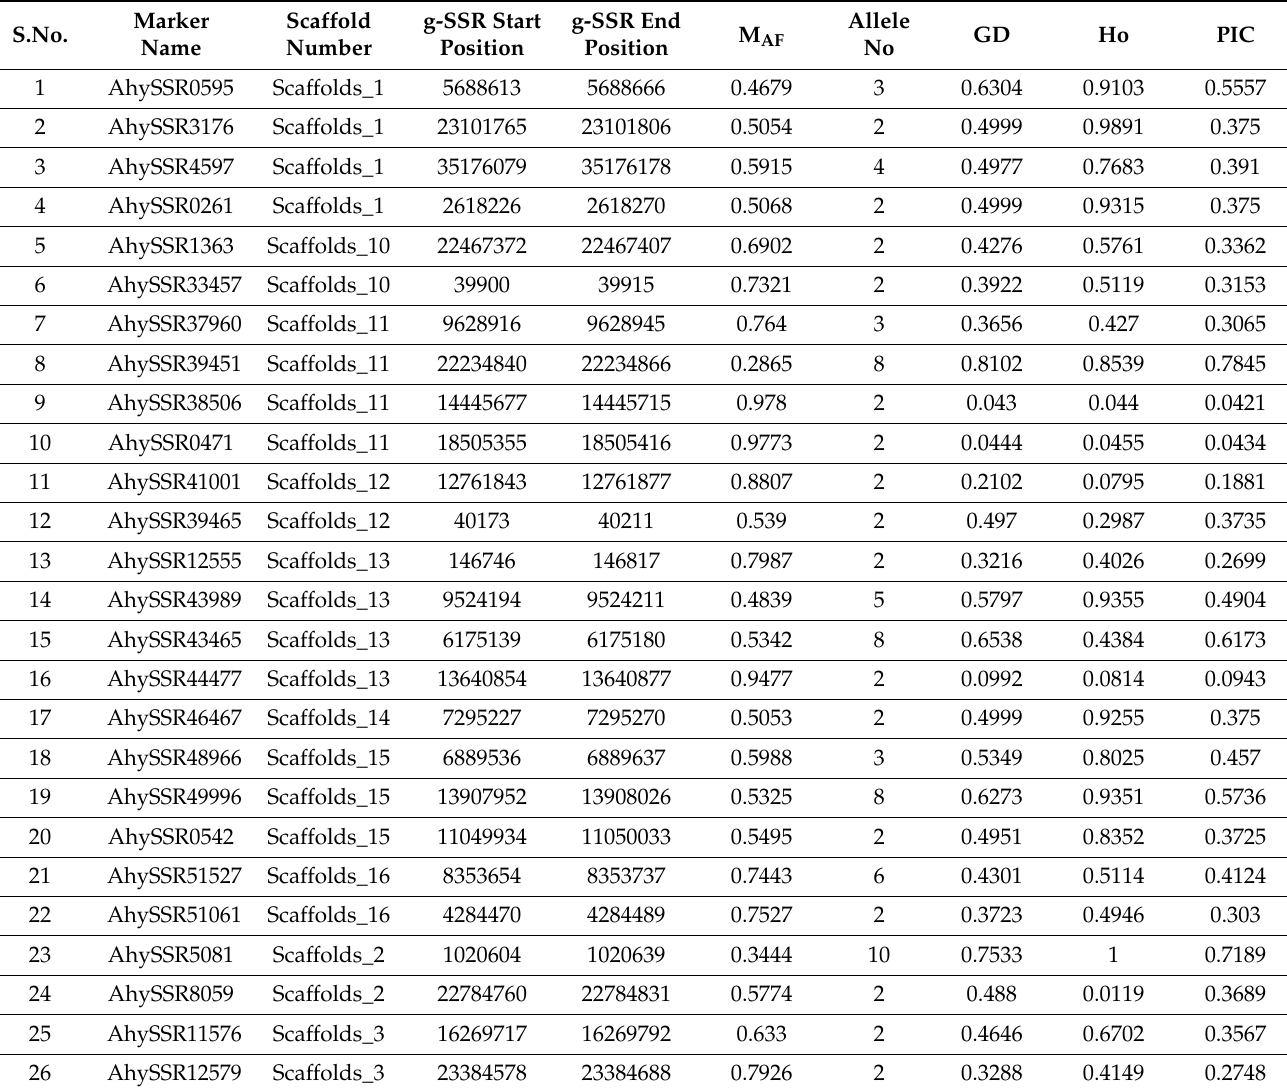
Table 1. Characteristics and genetic diversity indices of 36 g-SSR loci used for genotyping 94 accessions of A. hypochondriacus